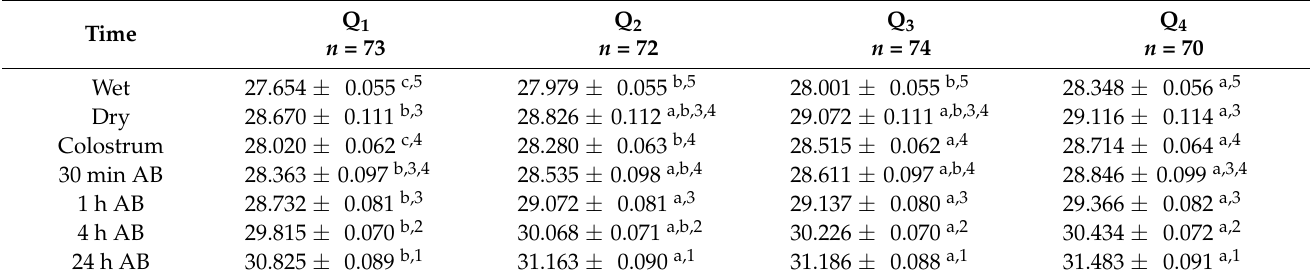
Table 6. The average temperature of the femoral pelvic limb (FPL) window at different times in newborn puppies classified into 4 groups according to weight.